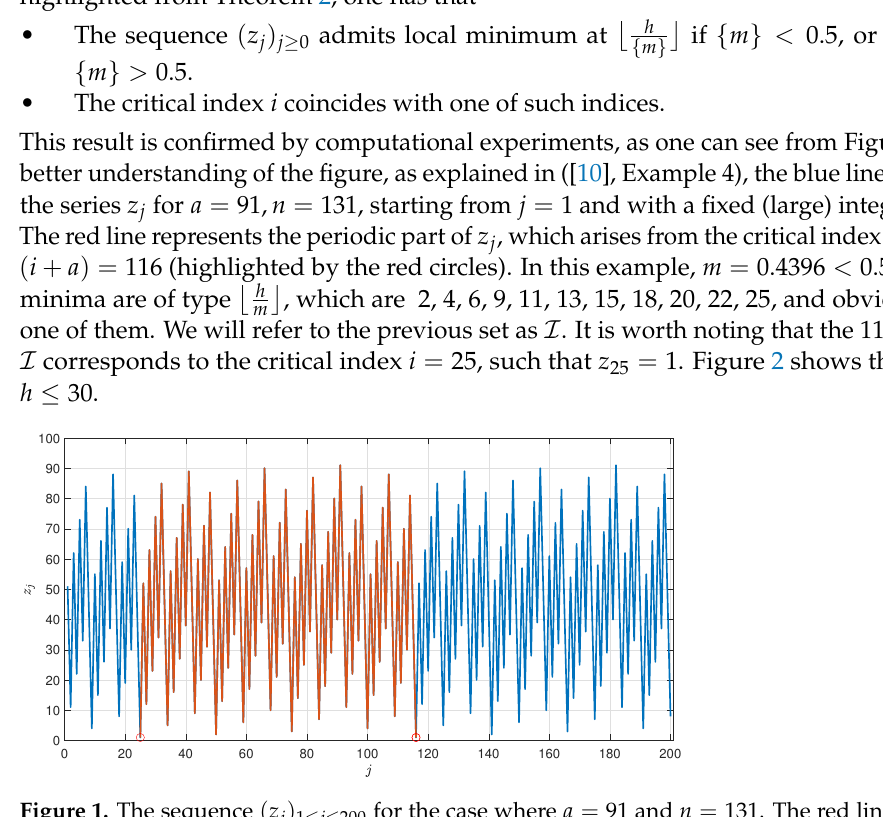
Figure 1. The sequence ( z j ) 1 ≤ j ≤ 200 for the case where a = 91 and n = 131. The red line highlights the entire sequence between two consecutive unitary values of z i (represented by red